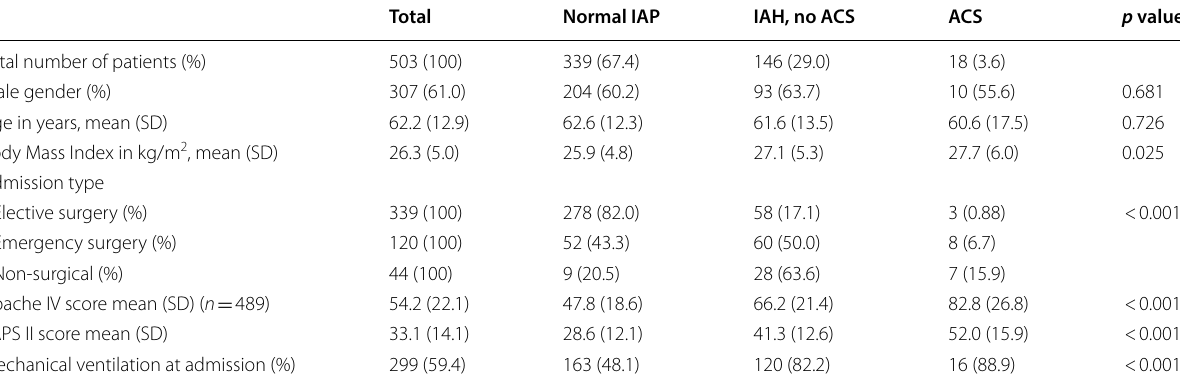
IAP intra-abdominal pressure, IAH Intra-abdominal hypertension, ACS Abdominal Compartment